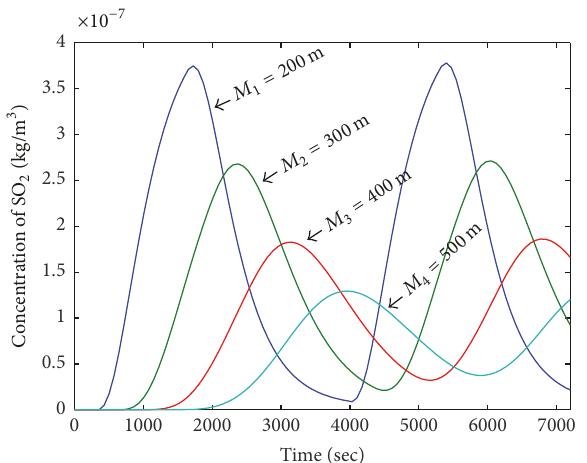
Figure 6: The concentration levels of air pollution after 58 minutes have passed which are controlled by air quality standard ( 3 × 10 −7 kg/m 3 ).